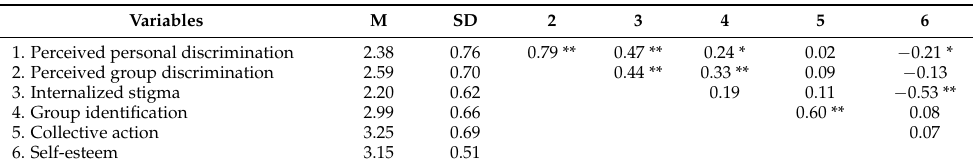
Table 1. Descriptive statistics and Pearson correlation coefficients for the sample of people with hearing impairments.